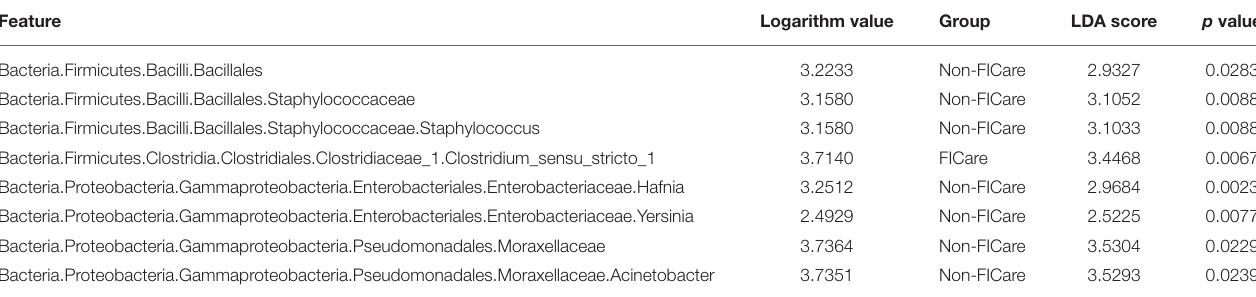
TABLE 5 | LDA effect sizes.